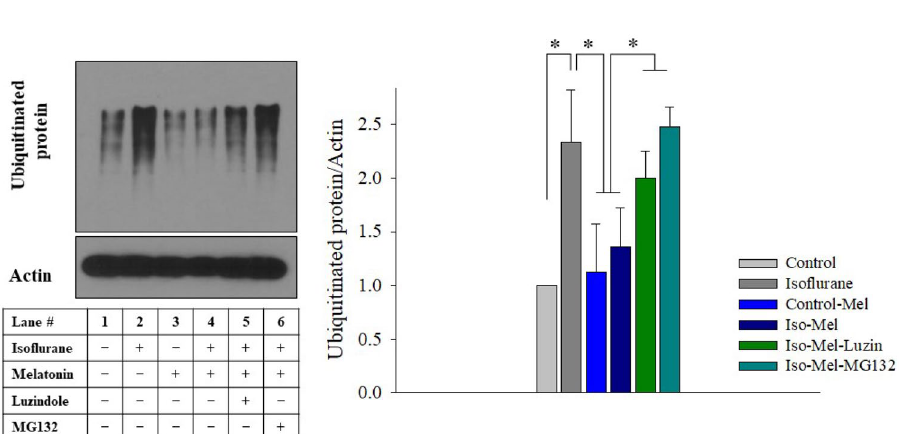
Figure 2. Expression of genes related to the unfolded protein response and endoplasmic reticulum-associated protein degradation pathways. ( A ) Increased ire-1 expression followed by repeated isoflurane exposure was suppressed by melatonin treatment. Luzindole attenuated the effect of melatonin on the level of ire-1 . ( B ) The expression of sel-1 , sel-11 , cdc-48.1 , and cdc-48.2 was significantly decreased after repeated isoflurane exposure. While the differences in sel-1, cdc-48.1, and cdc-48.2 expression were still significant between the control- melatonin and the isoflurane-melatonin groups, sel-11 expression was comparable between the two groups. All batches included three plates in each group, and the same assay was performed three times. Error bar, standard deviation; *P < 0.05; N.S., not significant.